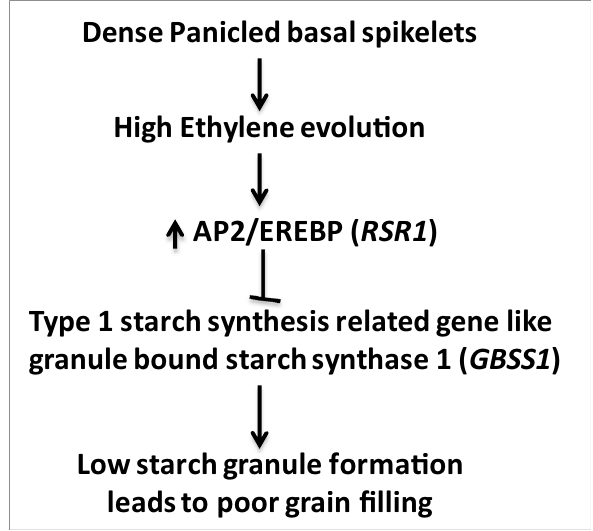
Figure 5. Model for poor grain filling in basal spikelets of dense panicle of rice, regulated by phytohormone ethylene . AP2-EREBP acts as a negative regulator of starch synthesis related genes leads to poor grain